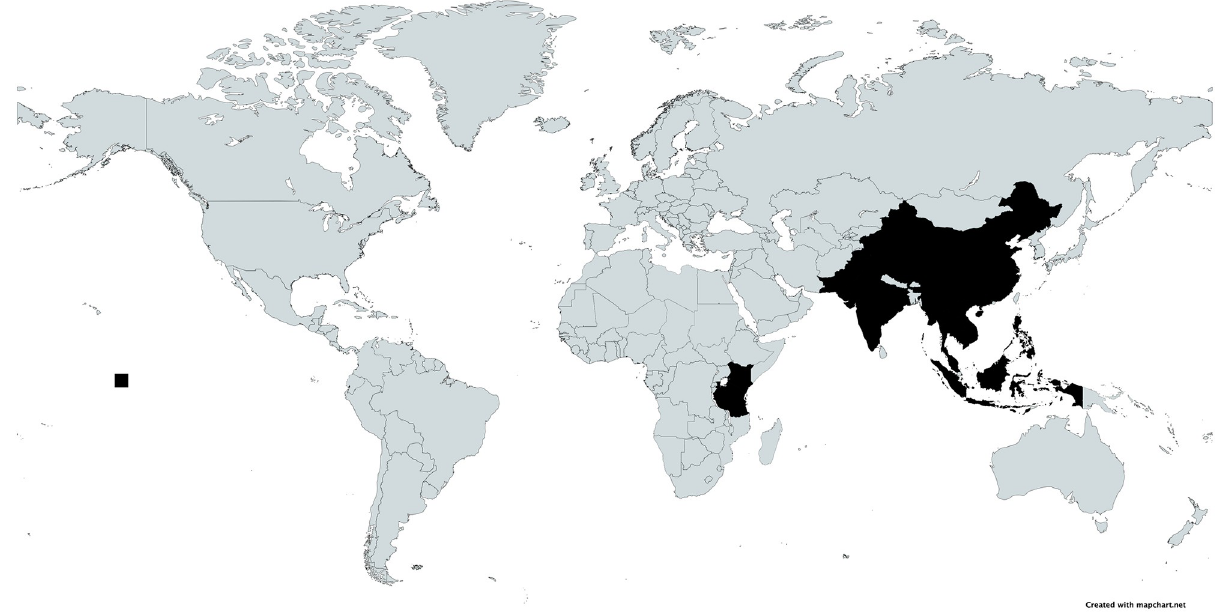
Fig 2. Map of included countries. Black = Country included in systematic